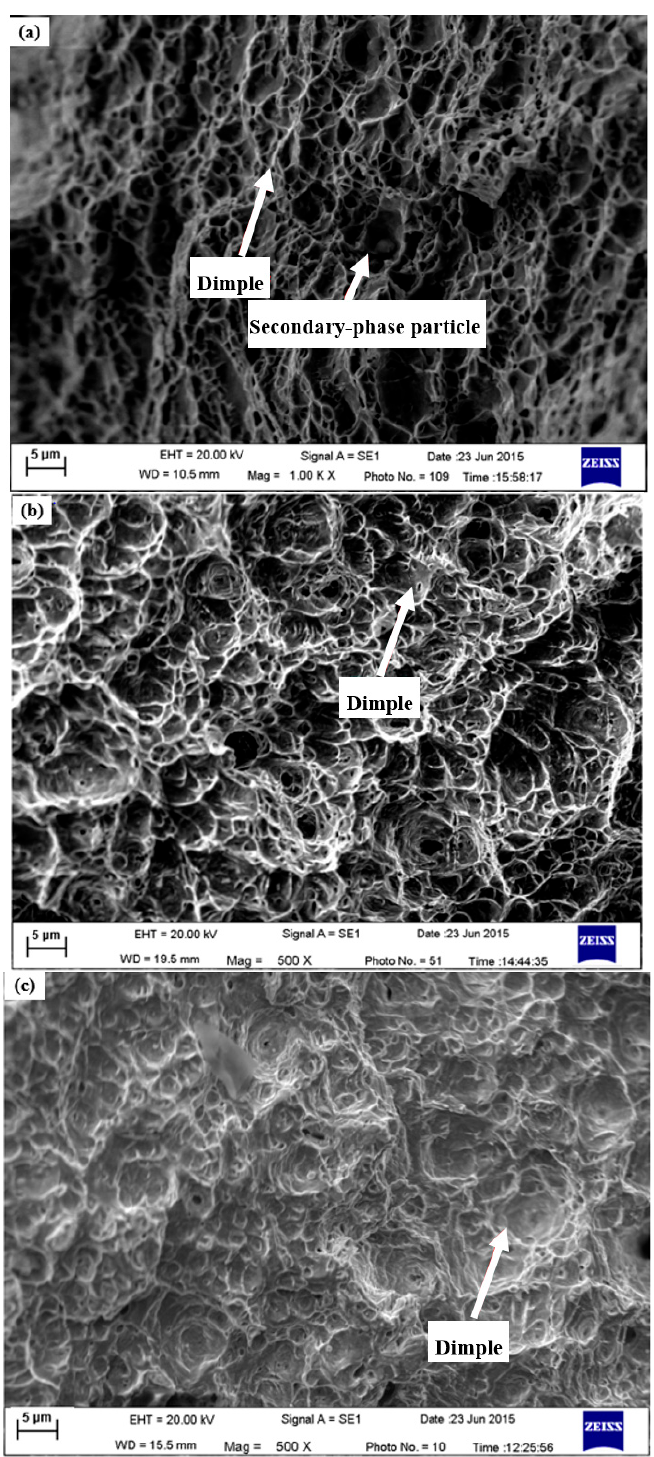
Figure 9. Fracture surface in ultimate fracture area: ( a ) the BM; ( b ) the HAZ specimen; and ( c ) the WM specimen.